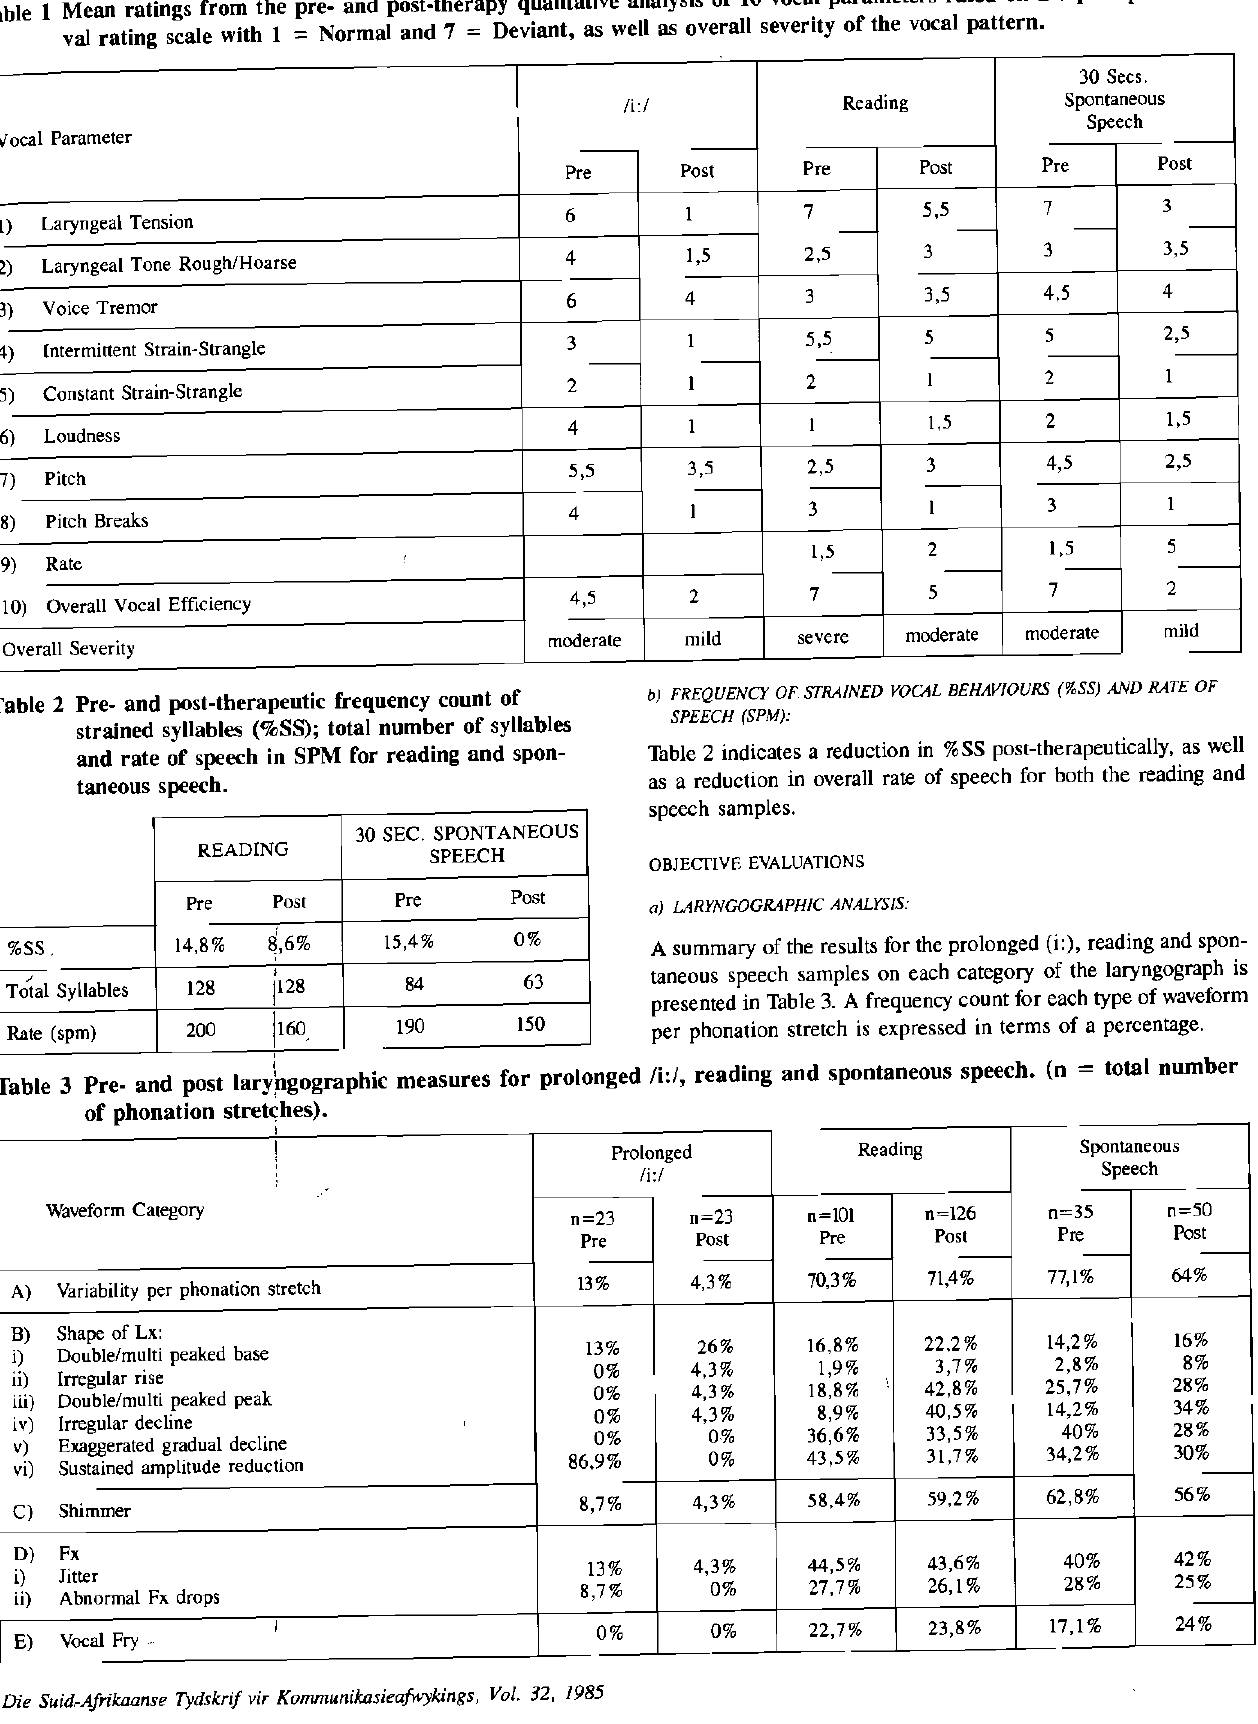
Table 1 indicates a summary of the results obtained for all three voice samples pre- and post-therapeutically. Table 1 Mean ratings from the pre- and post-therapy qualitative analysis of 10 vocal parameters rated on a 7 pt. equal inter- val rating scale with 1 = Normal and 7 = Deviant, as well as overall severity of the vocal pattern.